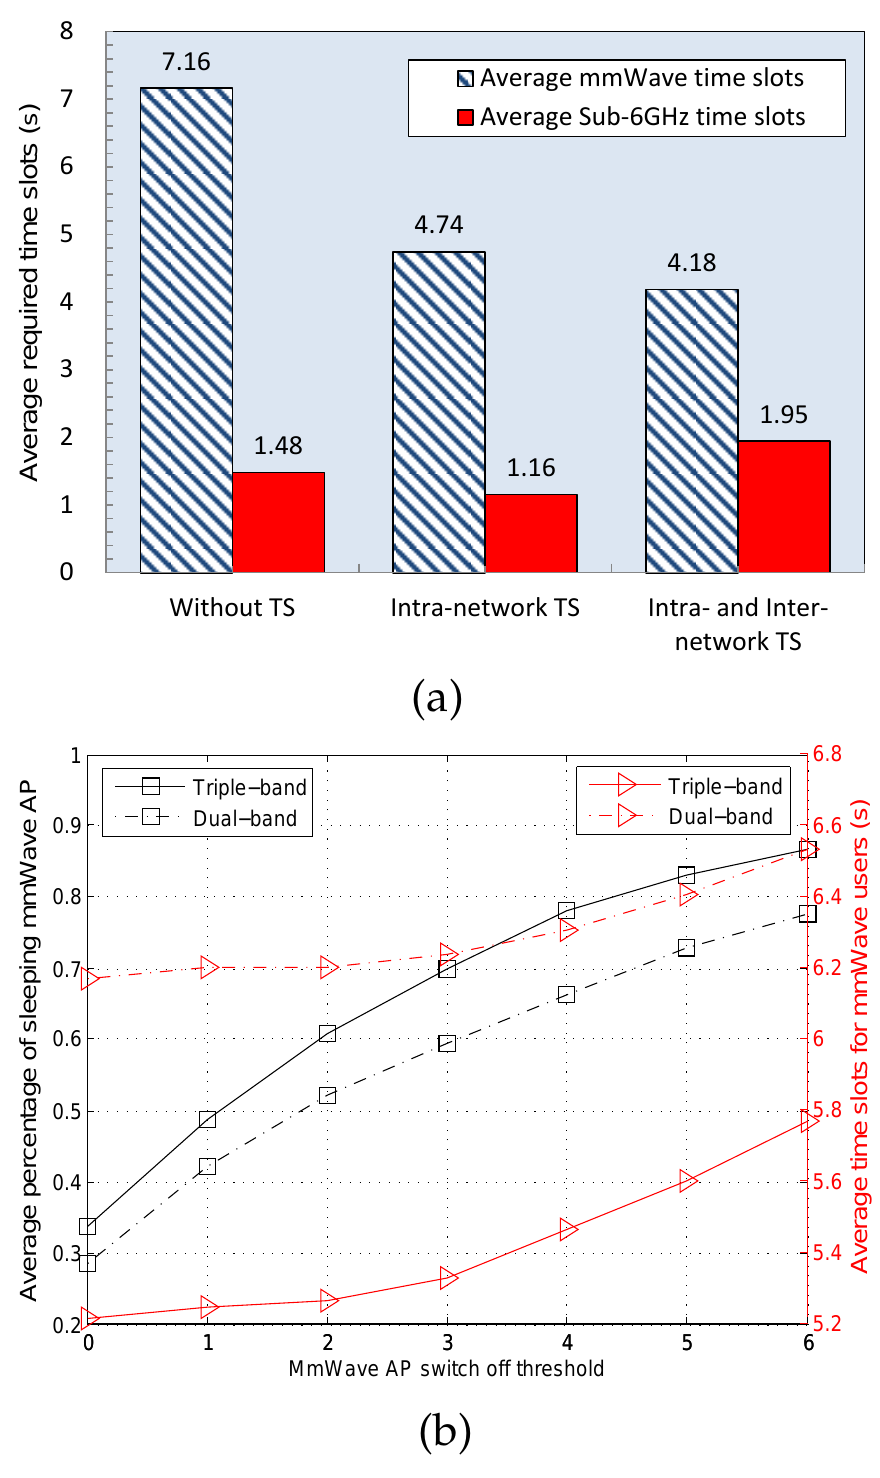
Figure 3. Simulation results: ( a ) Average required time slots in both mmWave and sub-6GHz unlicensed bands. ( b ) Average percentage of sleeping mmWave AP and the related time slots of mmWave users under different switch off thresholds.